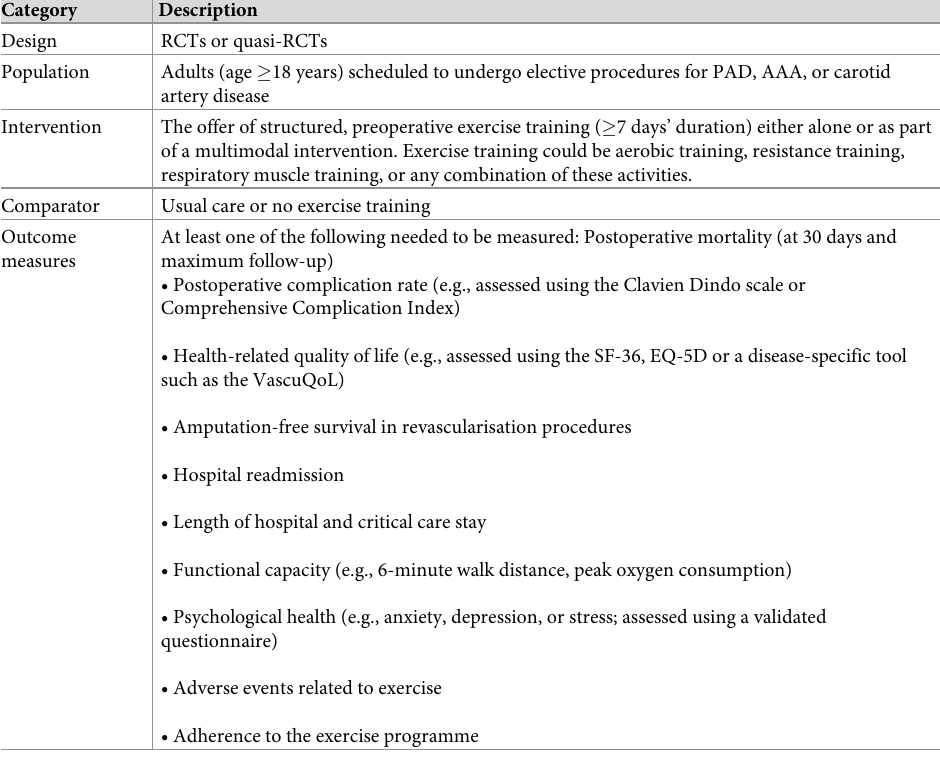
Table 1. Inclusion